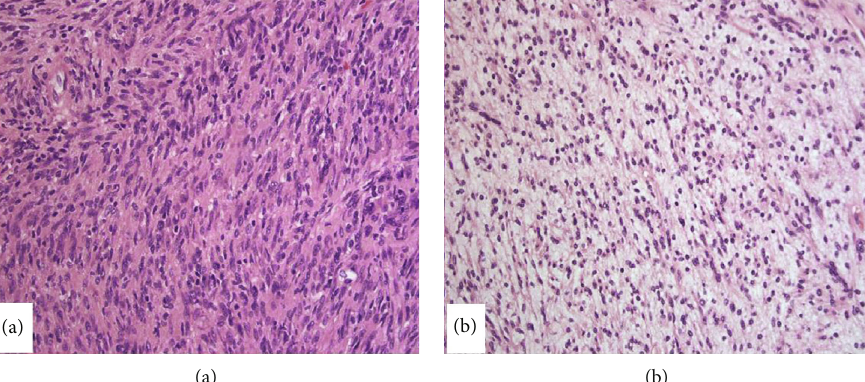
Figure 1: Legend: H&E section (20x) shows a spindle cell tumor composed of (a) hypercellular areas with vague nuclear palisading and (b) hypocellular areas with a myxoid background.